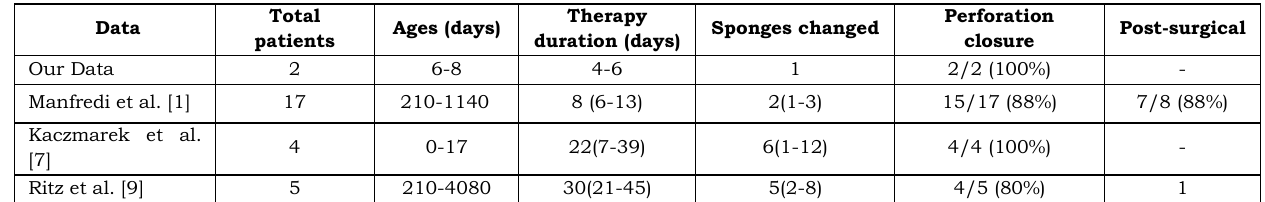
Table 2. Characteristics of patients with esophageal leak treated with